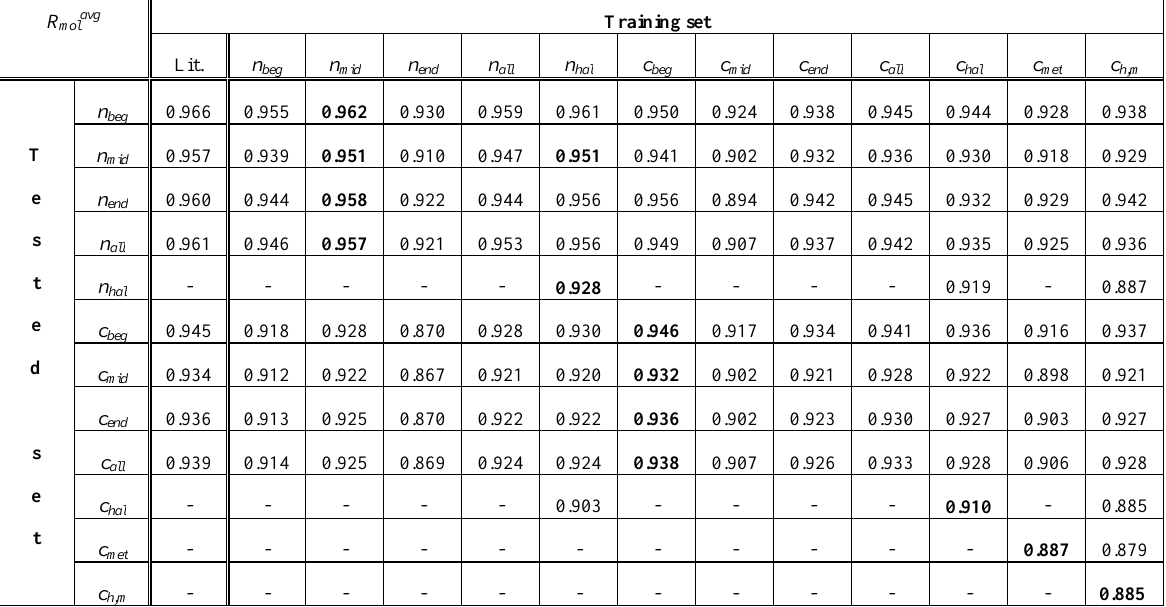
Table 2: Quality of parameters that were obtained by EEM parameterization using all training sets. R molavg Training